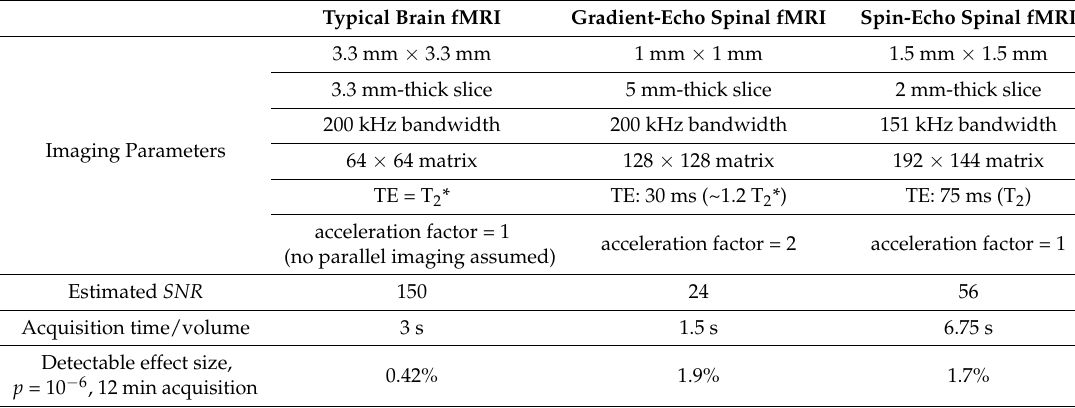
Table 2. Estimates of SNR for commonly used spin-echo and gradient-echo spinal fMRI acquisitions. SNR values are estimated compared to a typical brain fMRI method, which is assumed to have an SNR of approximately 150 at 3